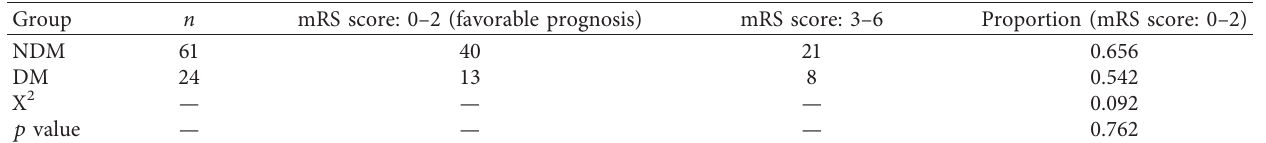
Table 5: Comparison of mRS scores at discharge after rtPA thrombolytic therapy of both groups. Group